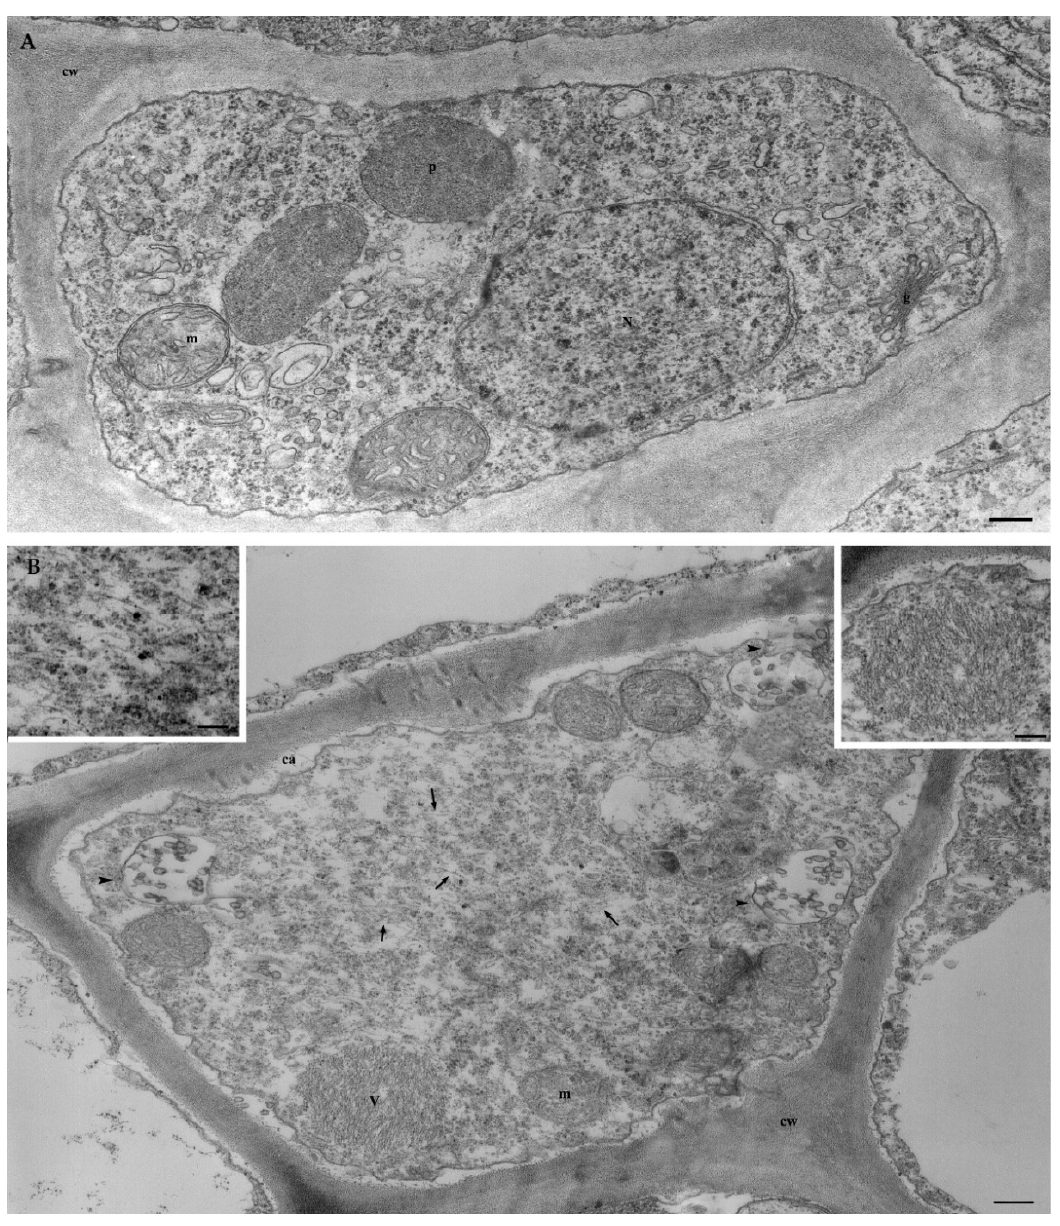
Figure 3. ( A ) Virus-free phloem cell showing the normal appearance of the cytoplasm and organelles. N = nucleus; m = mitochondria; p = peroxisome; g = Golgi; cw = cell wall. Bar = 250 nm. ( B ) Cell in a vascular bundle of vine co-infected by GVG and GLRaV3 shows scattered fine particles (arrows and enlarged left inset) and tonoplast or cell membrane-associated vesicles (arrow-heads) for the vitivirus GVG, and an aggregate of virus particles (V) for the ampelovirus GLRaV3 (enlarged right inset). Massive appositions to the cell wall (cw) of callose-like material (ca) have been observed. m = mitochondria. Bar = 250 nm; inset = 100 nm.